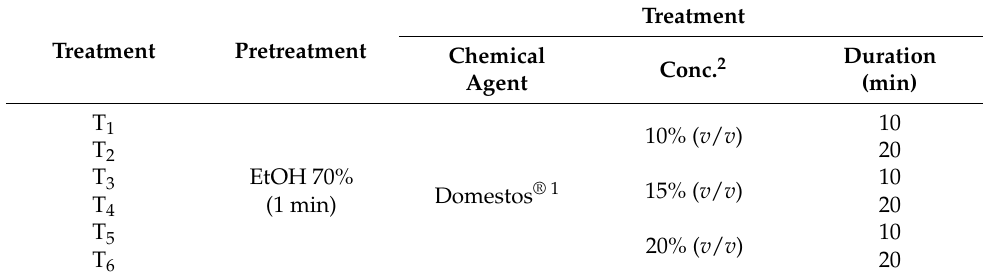
Table 2. Asepsis treatments experiment for testing the sterilization efficiency of SB